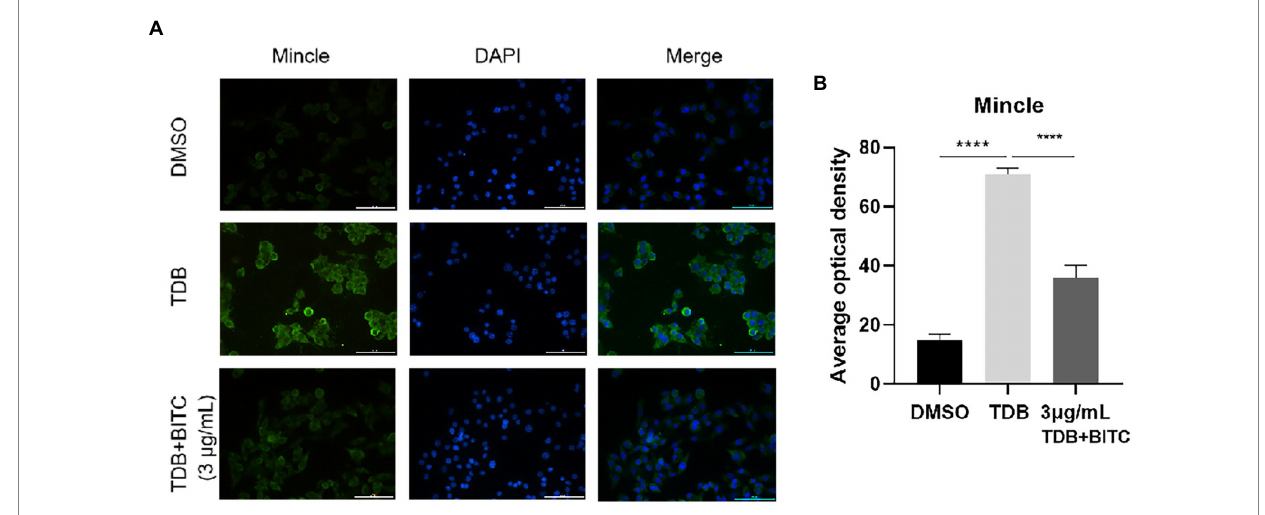
FIGURE 8 The immunofluorescence staining (A) labeled Mincle protein in RAW264.7 cells stimulated with TDB and treated by DMSO or BITC. Quantitative analysis of Mincle protein levels (B) was conducted by Image J. Values represent as means ± SD. (**** p <